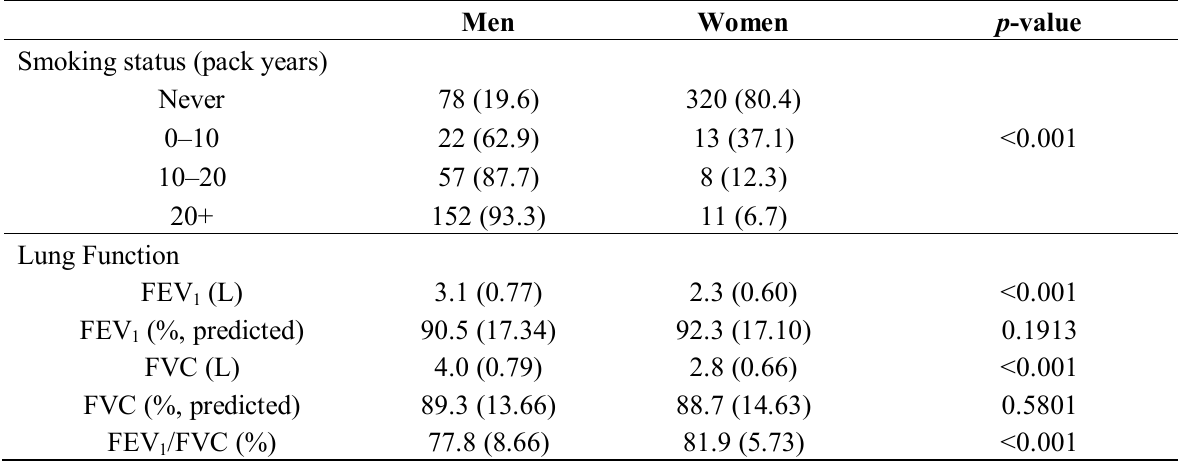
Table 1. Participants smoking status * and lung function ** by